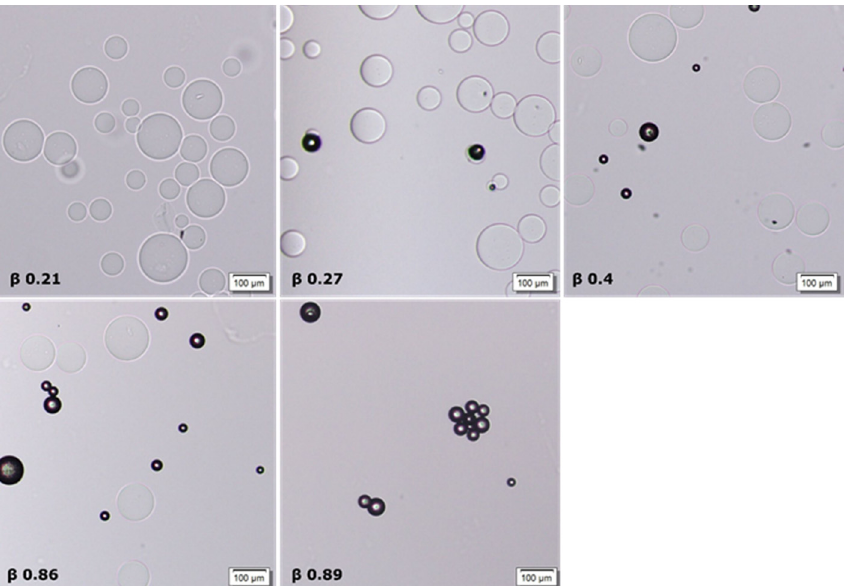
Figure 10. Polyacrylate microgels after equilibration with AMT solution at 155 mM ionic strength. Pictures taken at different binding ratios.